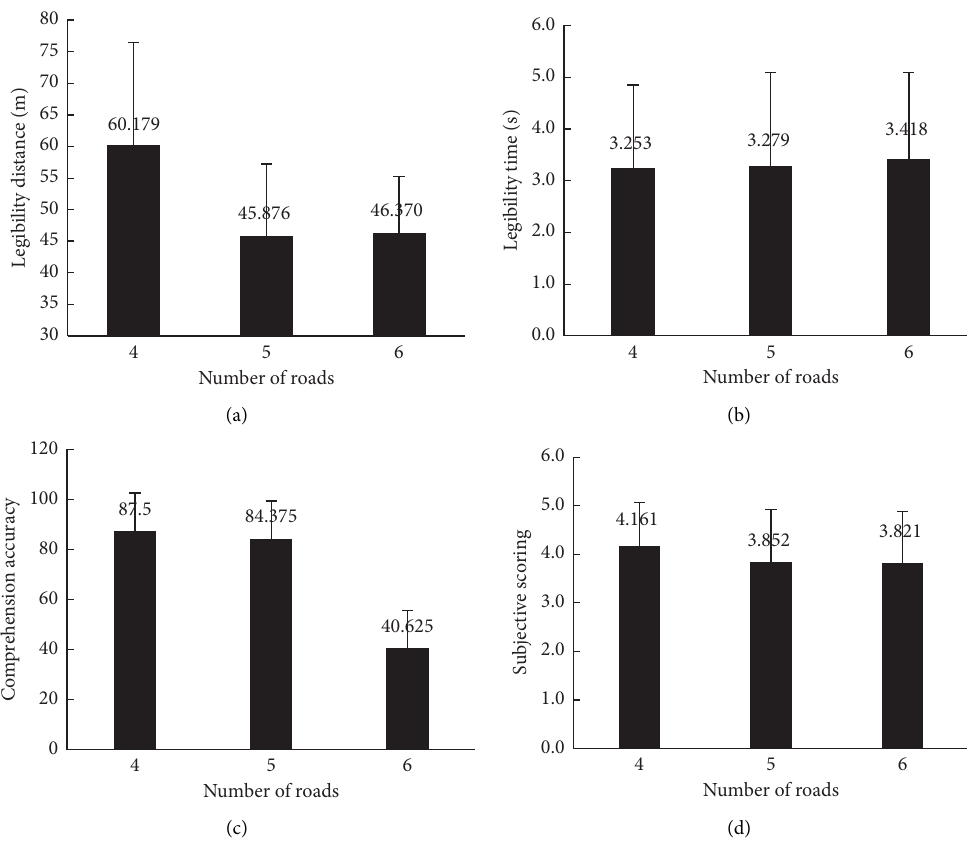
Figure 9: Statistical results of dependent (iv) Subjective scoring is the overall subjective evalua- tion of the VMS displayed by each participant. Te Figure 7. Tese four indices are defned as follows: (i) Legibility distance refers to the distance between the driver’s legibility point and the VMS position (ii) Legibility time was considered as the time taken by the driver to observe the information on the VMS and confrm the display of the information (iii) Comprehension accuracy is the percentage of participants who correctly identify VMS information